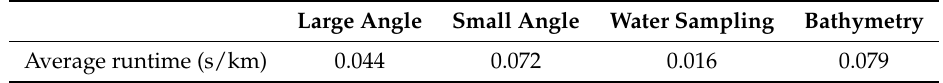
Table 4. Average runtime of algorithm.